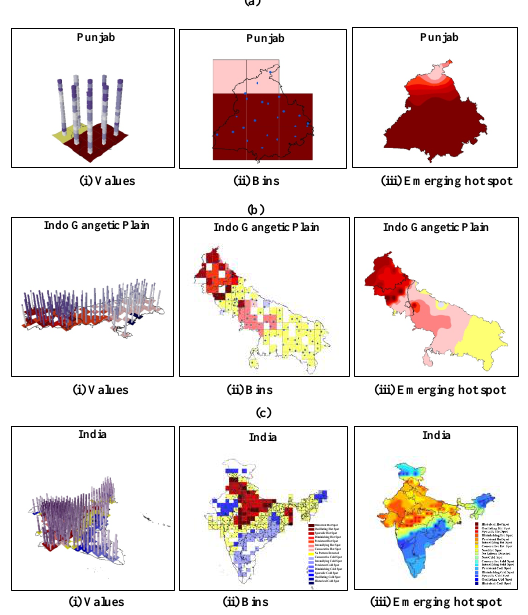
Figure 4 Emerging cold and hot spot outputs for three different spatial domains of Wheat cultivation for yield local (Punjab state) (neighbourhood distance: 11.3 km); (b) subnational (Indo Gangetic Plain) (neighbourhood distance 25 km); and (c) national (neighbourhood distance 50 km).